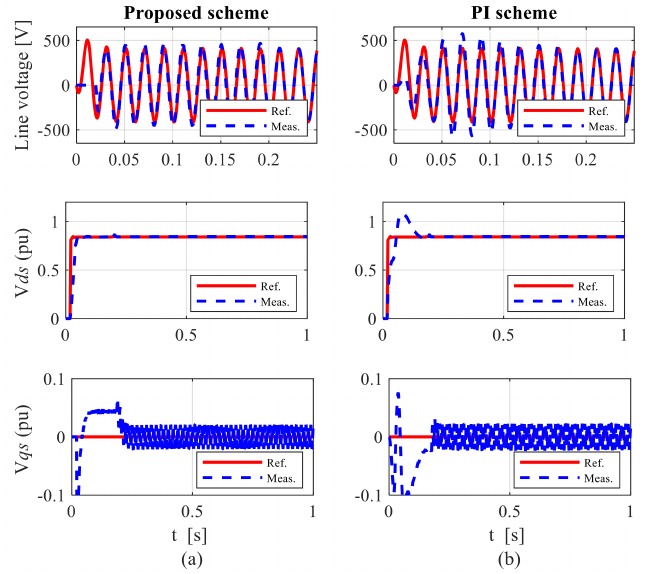
Figure 11. Control performances during super-synchronous speed operation under unbalanced grid conditions for L m(perturbed) = 200% L m : ( a ) proposed scheme and ( b ) PI scheme.